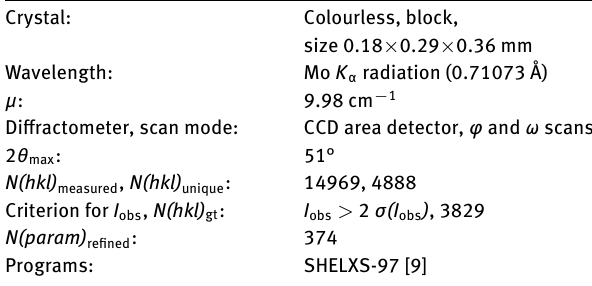
Table 1: Data collection and handling.